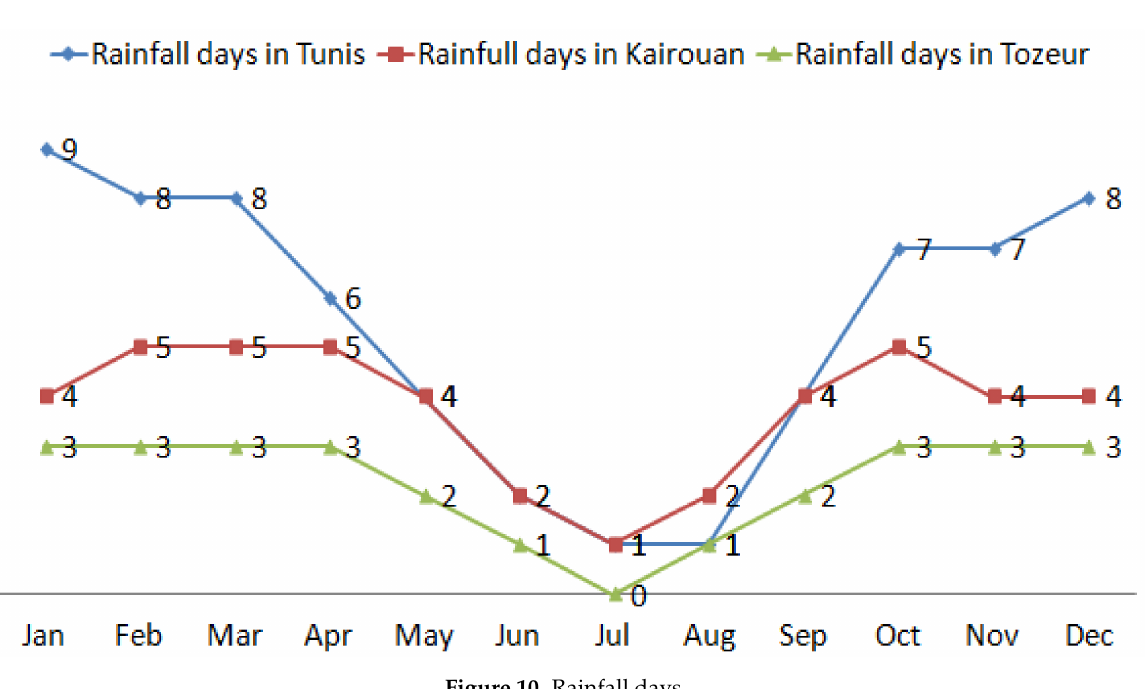
Figure 10. Rainfall